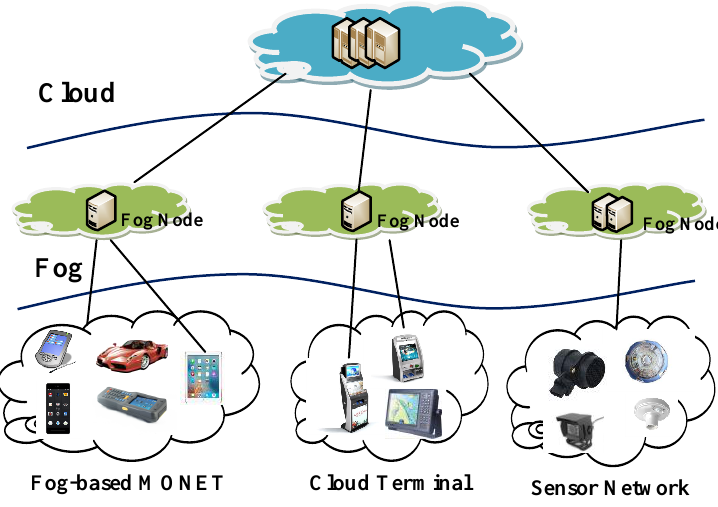
Figure 1. Architecture of the Fog-based MANET.